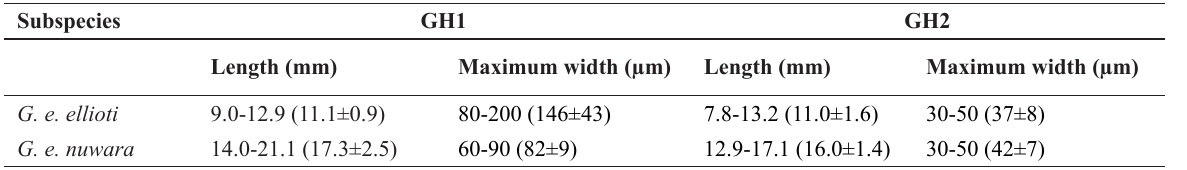
Table 1: Width and length of Guard Hair 1 (GH1) and Guard Hair 2 (GH2) of G. e. ellioti and that of G. e. nuwara (Niroshani and Meegaskumbura, 2015)